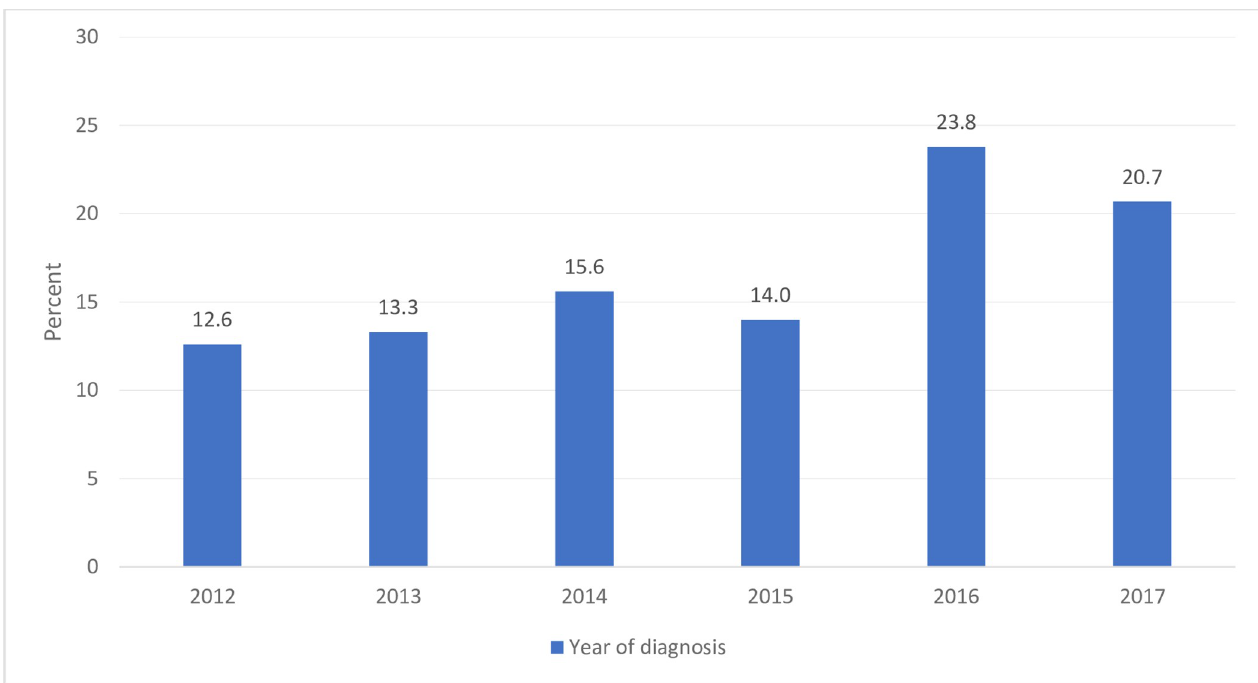
Fig 2. Time trends. Oesophageal cancer cases in in Ethiopia from 2012 to 2017.